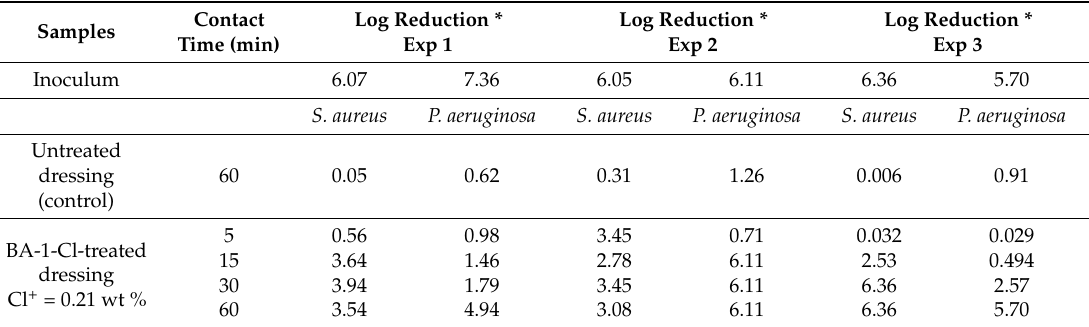
Table 3. Biocidal efficacy of BA-1-Cl coated wound